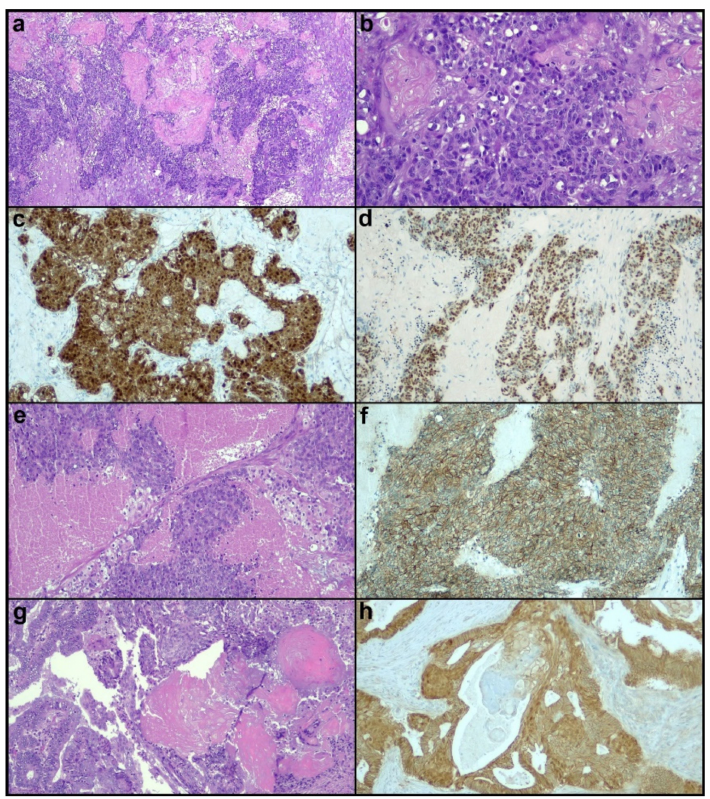
Figure 2. ( a – d ) Ovarian PiMHEC characterized by solid nests of basaloid cells with prominent ghost cell keratinization (( a , b ), hematoxylin-eosin, magnification 40 × and 200 × ), nuclear β -catenin expression (( c ), 100 × ) and CDX2 positivity (( d ), 100 × ). ( e , f ) High-grade endometrioid carcinoma with basaloid cells and prominent necrosis; note the absence of ghost cells (( e ), hematoxylin-eosin, 100 × ) and the membrane β -catenin expression (( f ), 100 × ). ( g , h ) Low-grade endometrioid carcinoma with morular metaplasia and ghost cells; there is an admixture of morular metaplasia and low-grade glandular structures, with no high-grade basaloid cells (( g ), hematoxylin-eosin, 100 × ); β -catenin immunostaining highlights the presence of morular metaplasia (nuclear expression) and glandular structures (membrane expression) (( h ), 100 ×